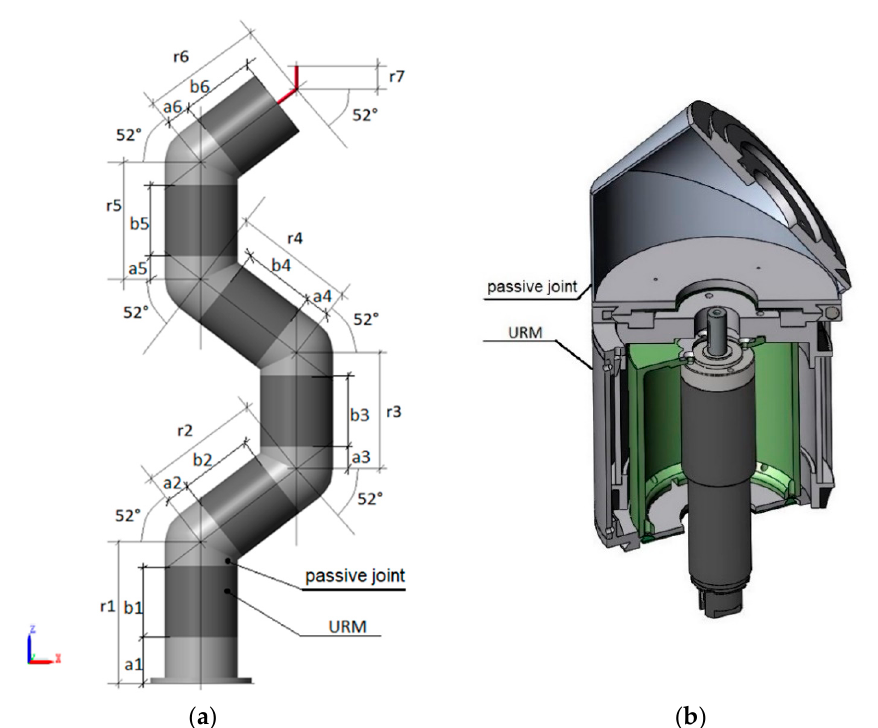
Figure 4. ( a ) Model visualization with hints of dimensions in Matlab-Simulink using the Sim- scape/Multibody toolbox. ( b ) Detail URM with a passive joint.